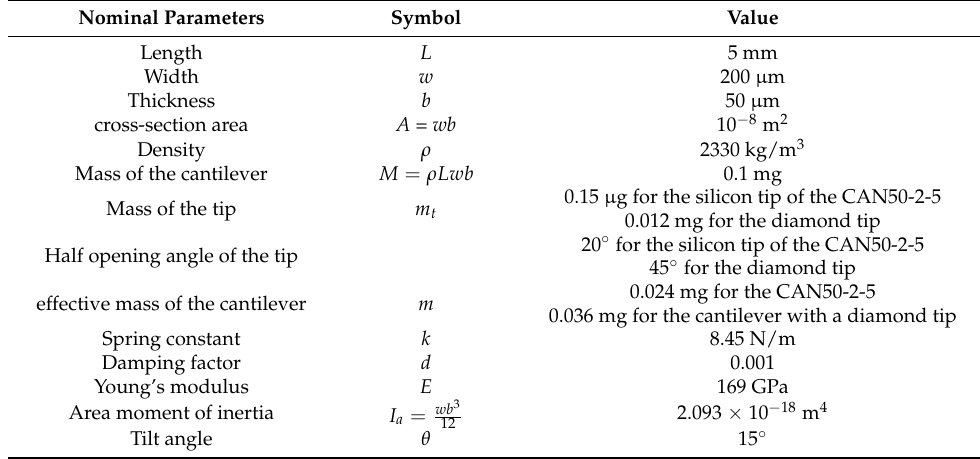
Table 1. Nominal parameters of the microprobe used to calculate the cantilever tip trajectories in Figures 3 and